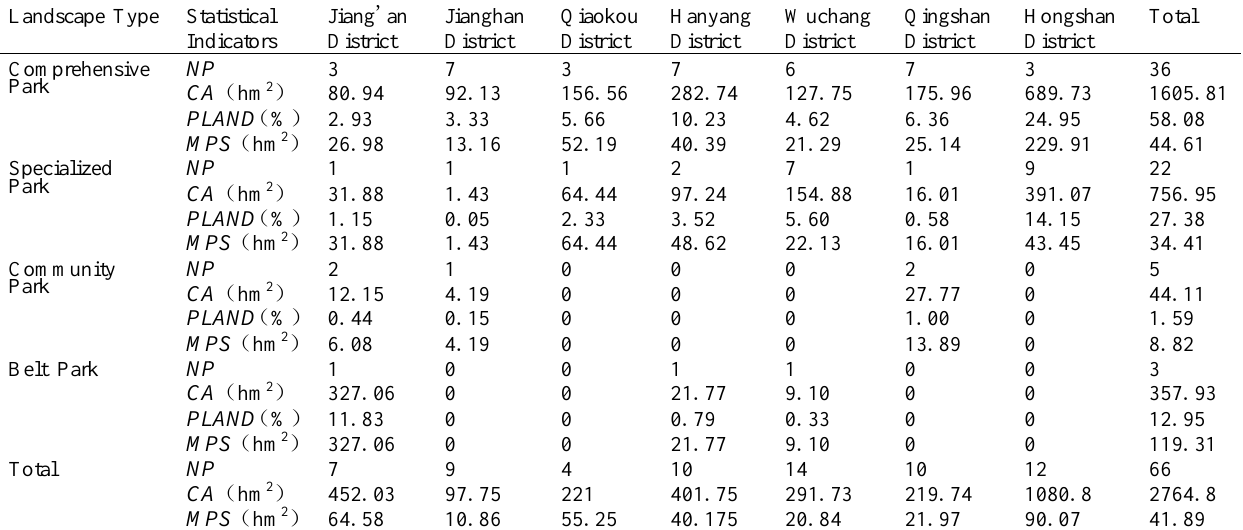
Table 2 . Statistics on the number and area of park green patches in the main urban area of